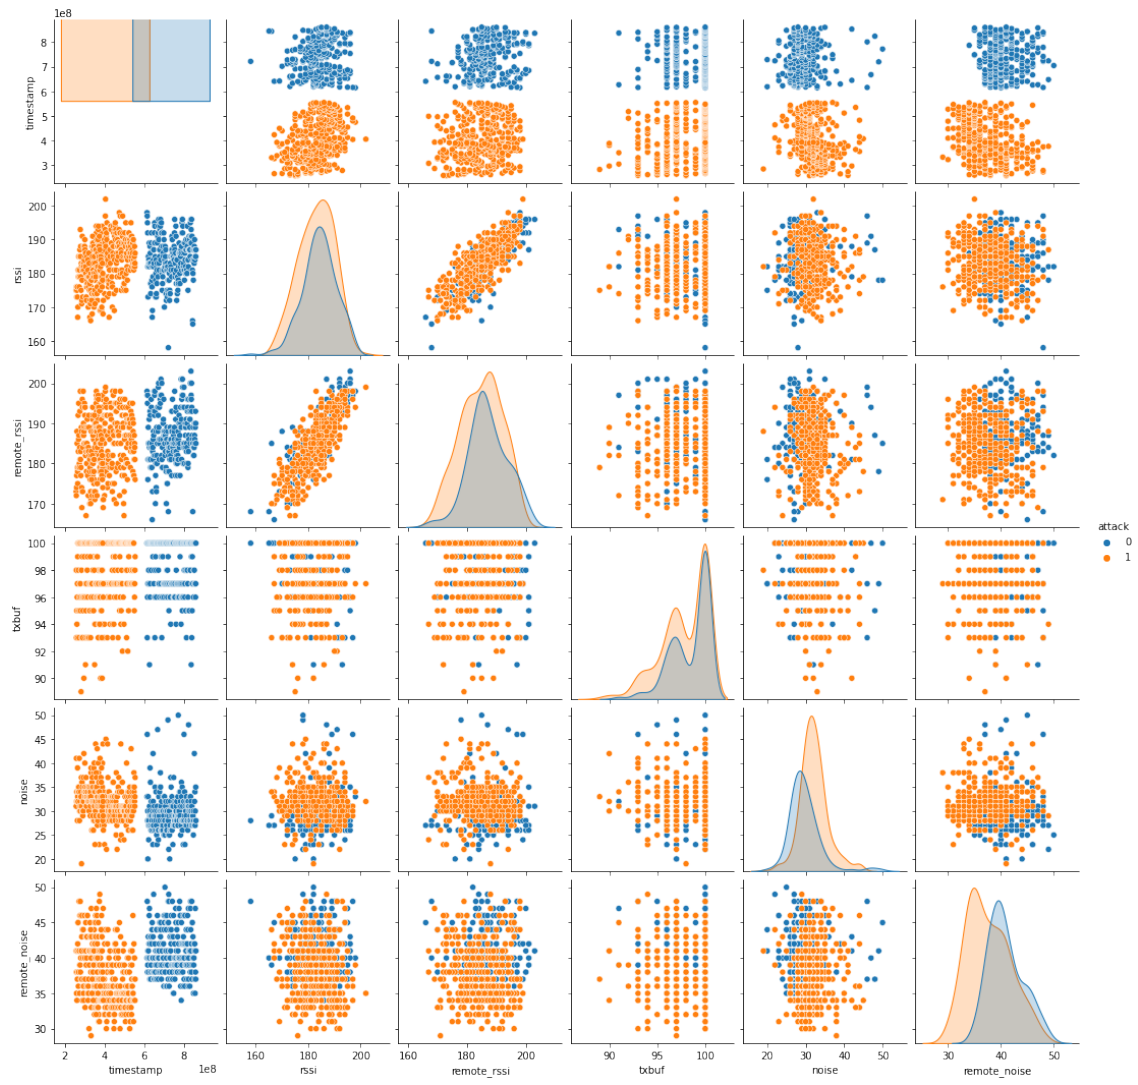
Figure 16. Pair plot analysis between attack and radio